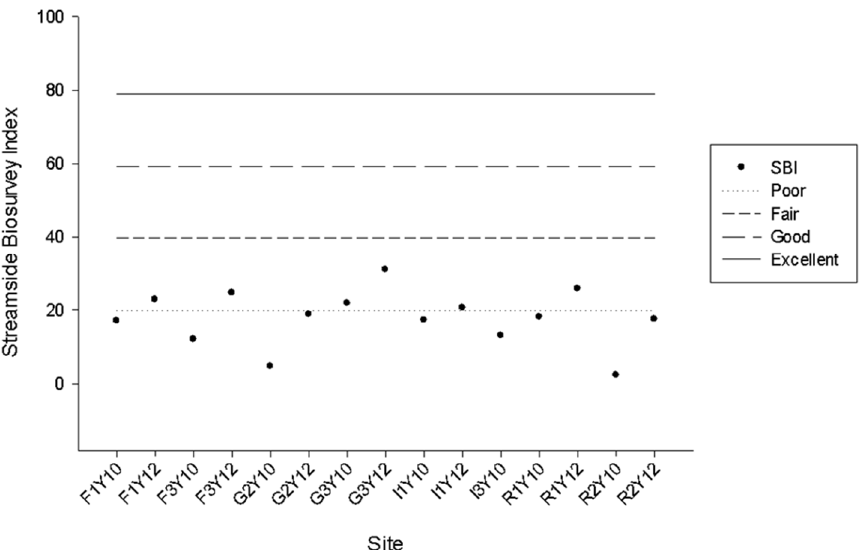
Figure 4. USEPA SBI scores at the 8 land use land cover treatment reaches in the Neponset River